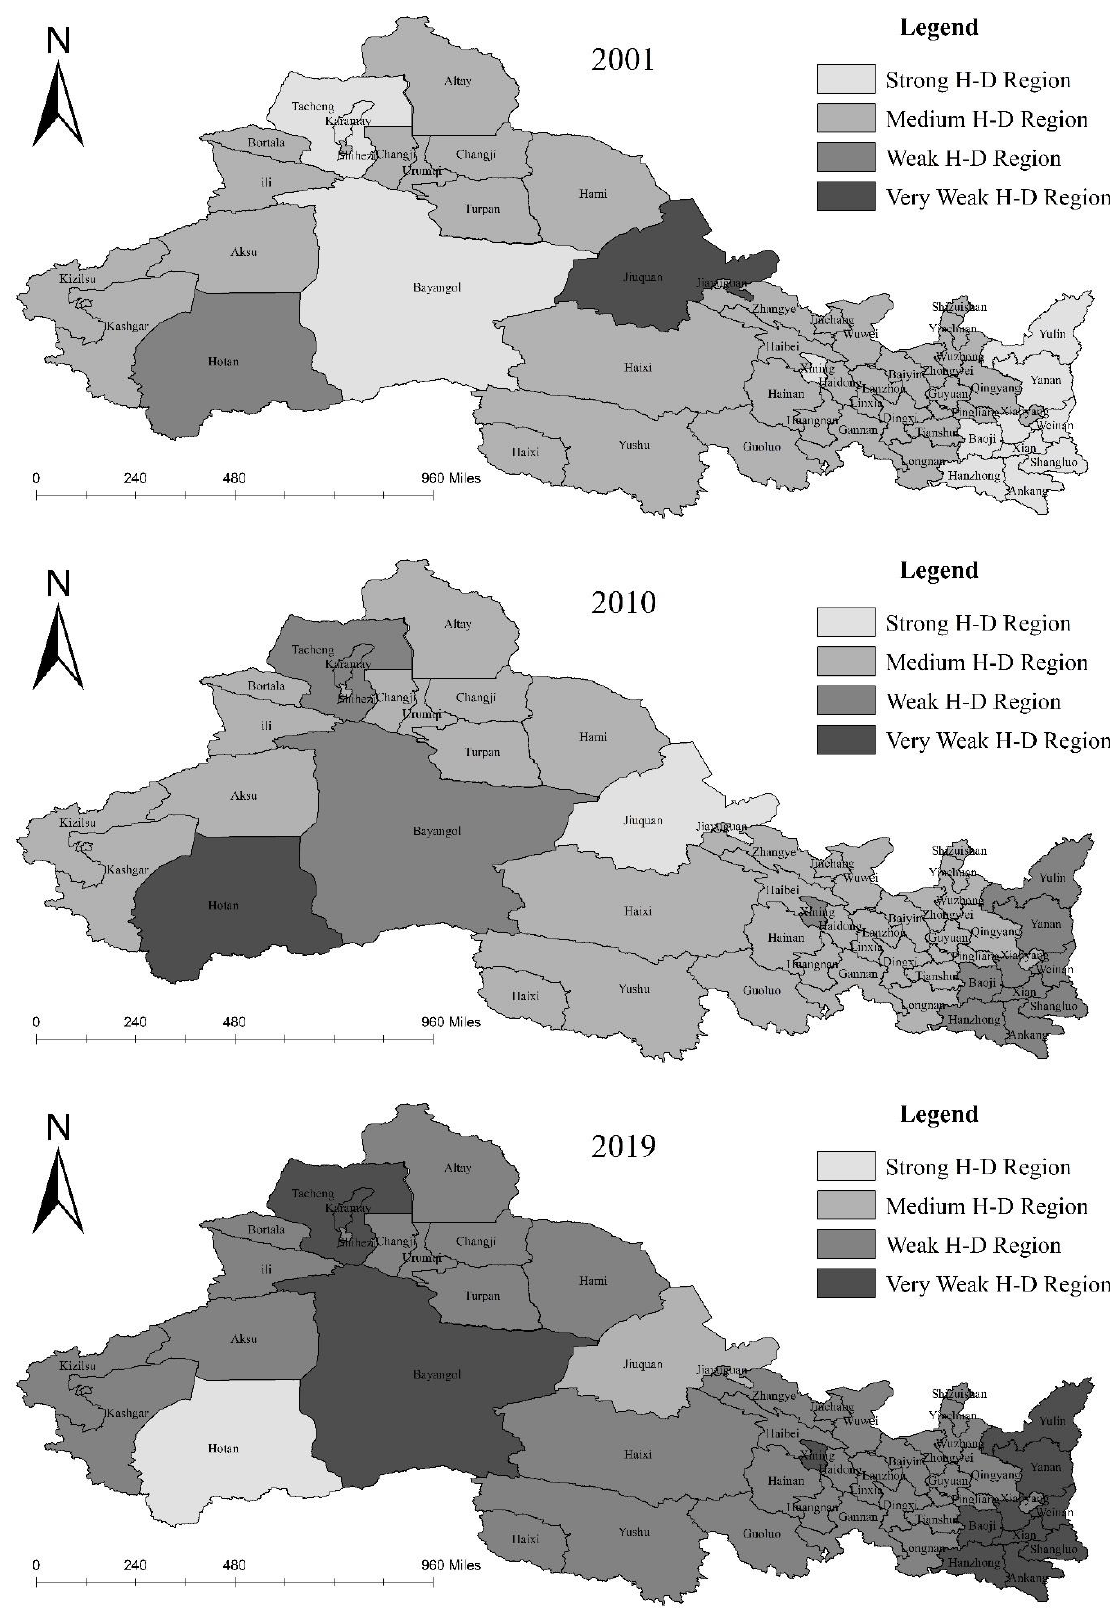
Figure 1. The types synergy of urban and rural water resources risks.